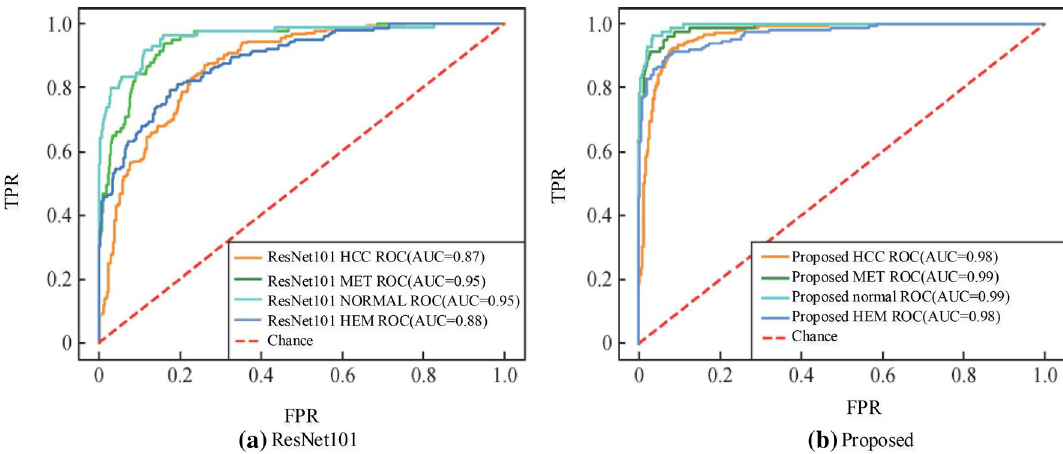
Fig. 11 ROC comparison between ResNet101 and proposed model